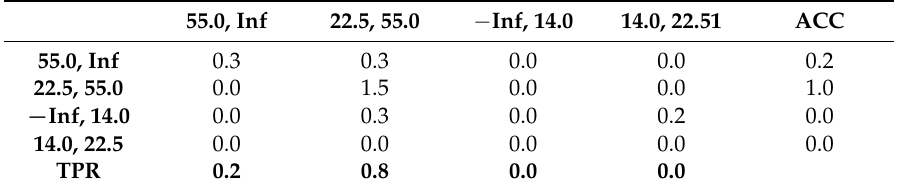
Table 3. Confusion matrix for UPDRS Total binned into four classes. Column headers represent predicted values and row headers represent actual